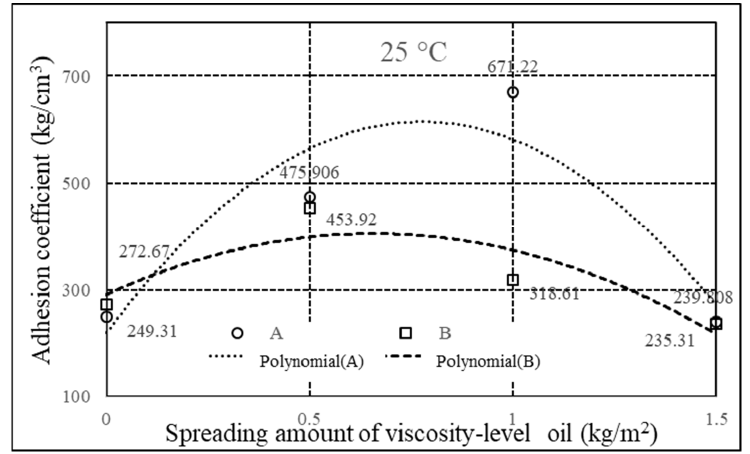
Figure 15. Adhesion coefficient curve of viscosity-level oil A and B specimens at 25 °C.